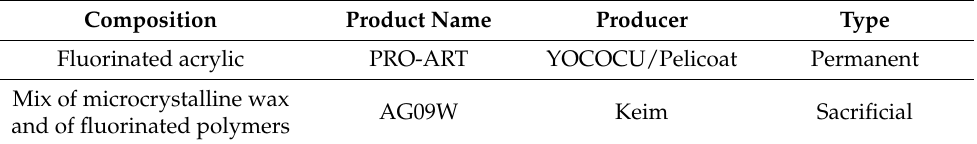
Table 1. Anti-graffiti coatings studied in the experimentation.